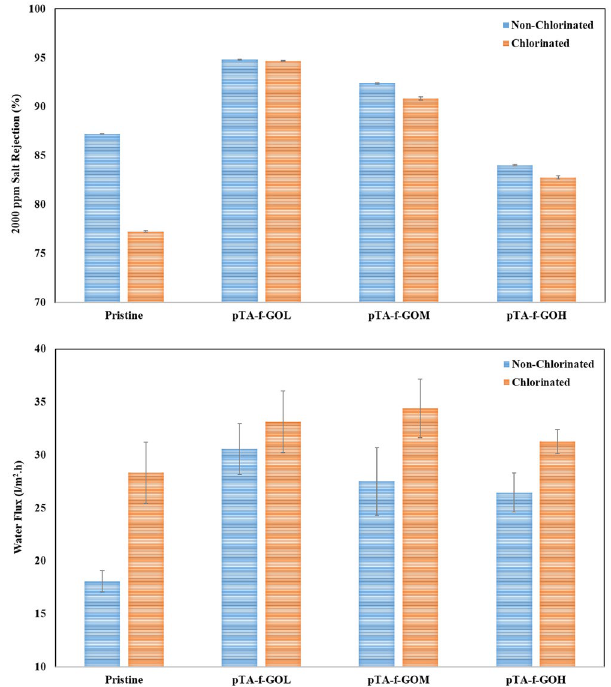
Figure 5. Water flux, salt rejection (%) and chlorine resistance performance of the pristine and fabricated membranes with various pTA-f-GO nanosheet